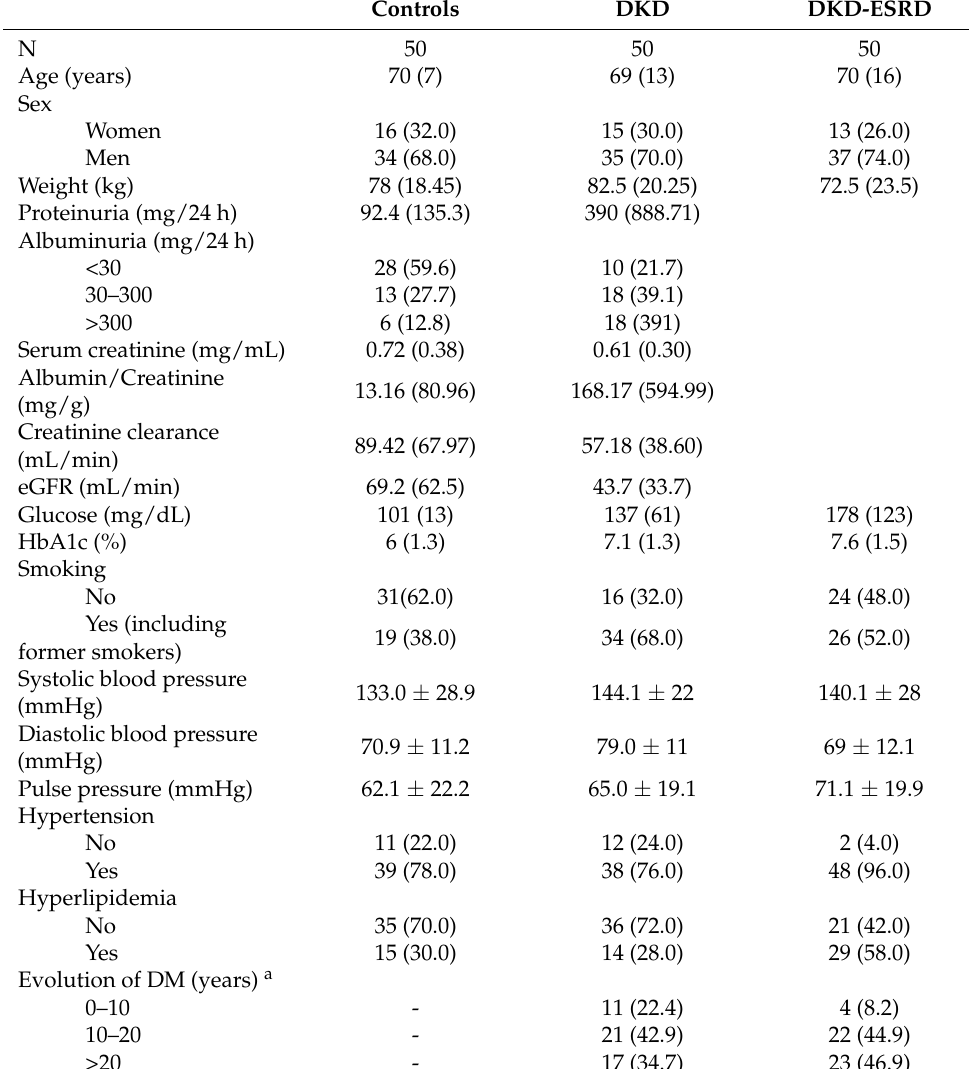
Table 1. Demographic and clinical characteristics of the discovery cohort. Data are shown as median (interquartile range), mean ± standard deviation or count